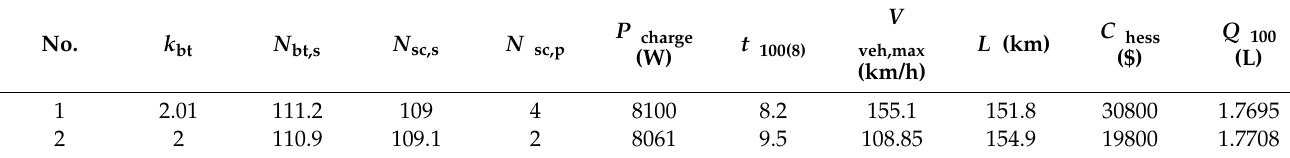
Table 10. The results with two sets of